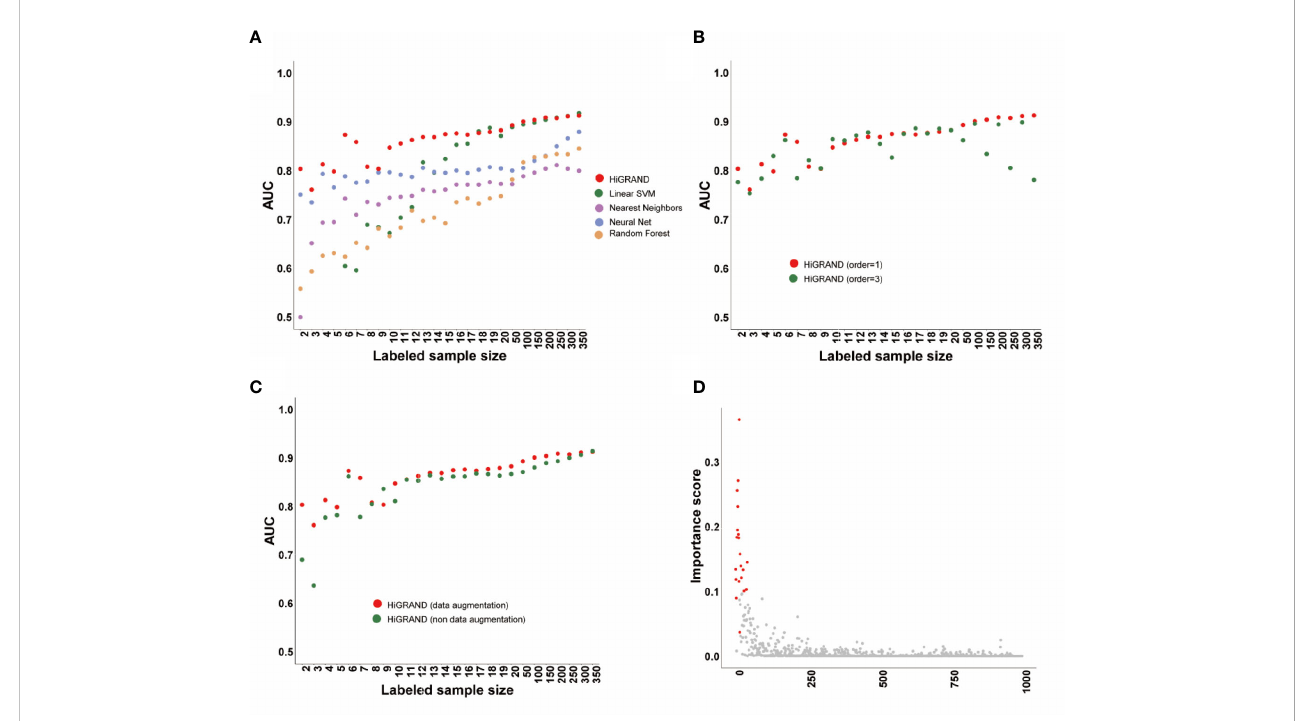
FIGURE 2 The performance of the HiRAND method on the simulation data. (A) The AUC of HiRAND and baseline models over all of the experiments on the simulation data. (B) The in fl uence of graph convolution step size on the AUC. (C) The in fl uence of data augmentation on the AUC. (D) The gene selection performance of HiRAND, where red represented differential variables and gray represented non-differential